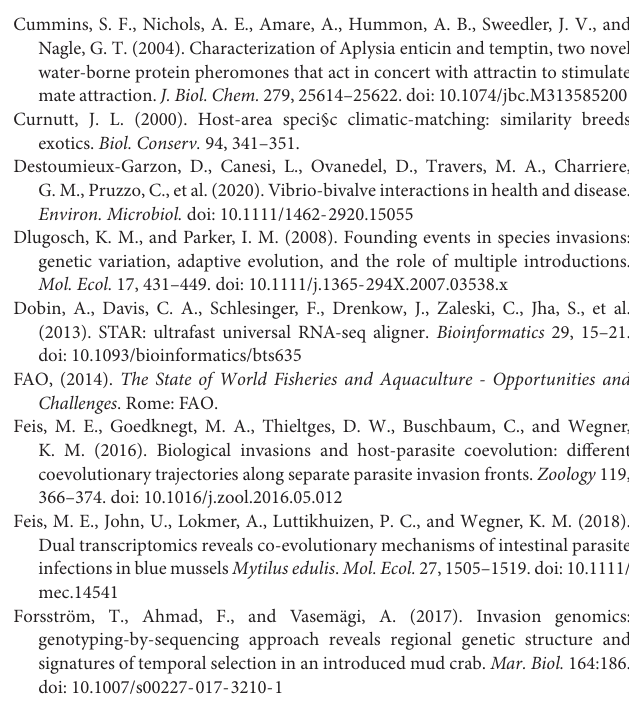
Supplementary Table 1 | List of significant differentially expressed genes